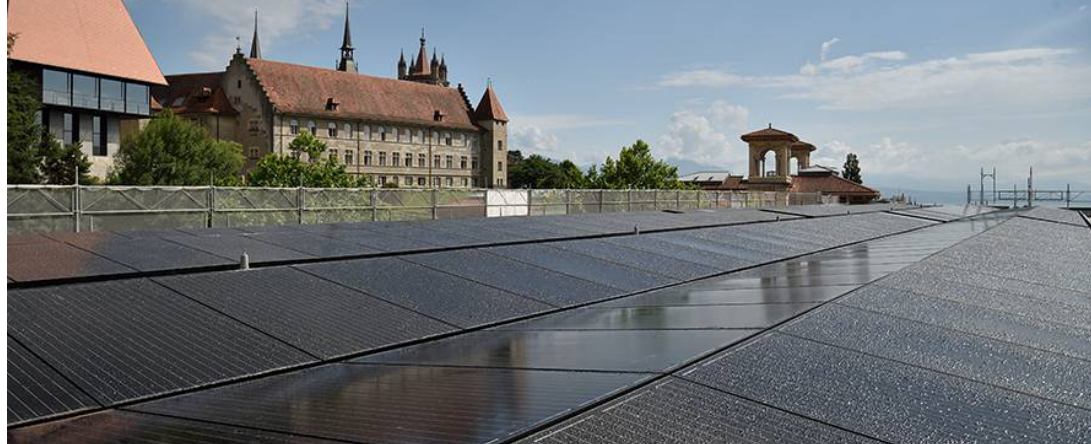
Figure 10. View of the photovoltaic roofing.